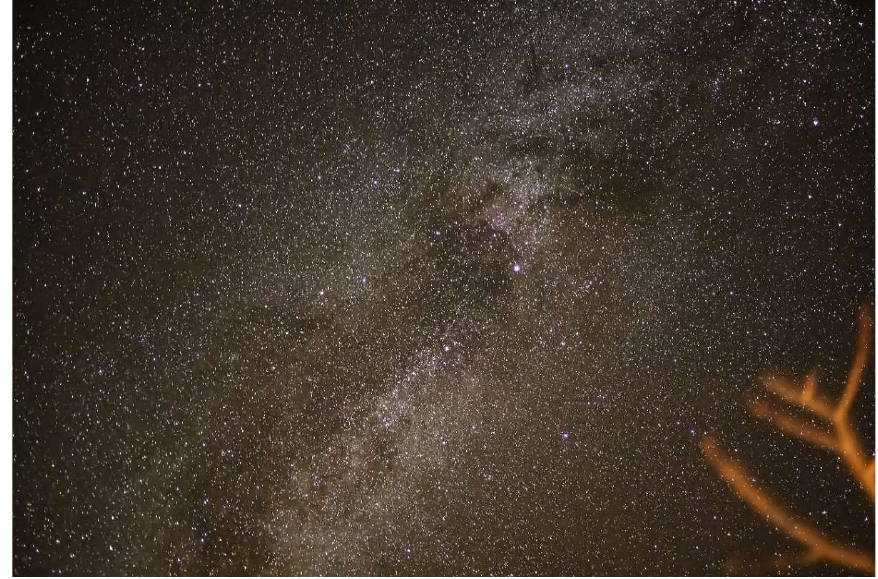
Figure 2. Night skies at 19th Rocky Mountain Virology Association meeting. Picture: exposure: 20 s; focal length: 40 mm; aperture: f / 1.7; ISO: 3200; credit, Dr. Joseph Timpona, University of Colorado Boulder.